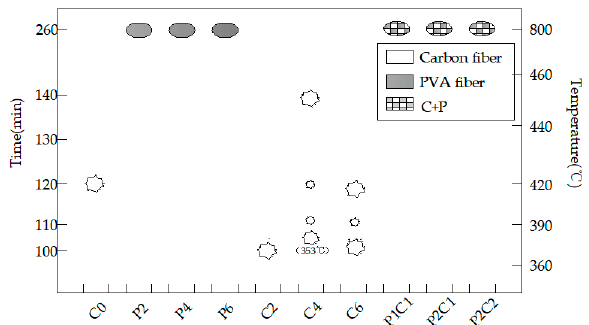
Figure 6. The burst statistics of concrete with different fiber contents.